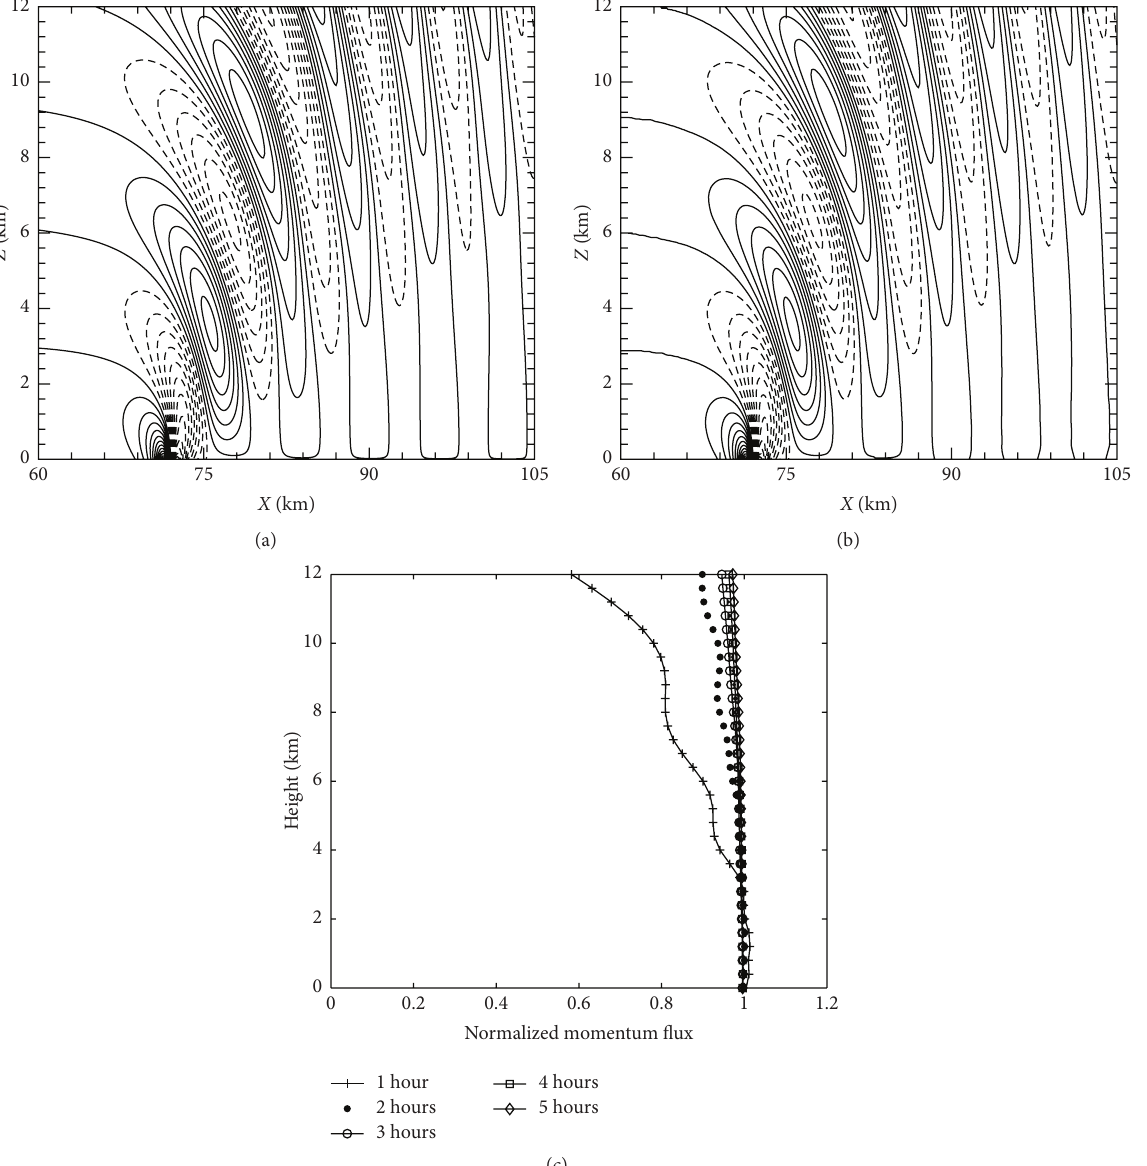
Figure 2: Same as Figure 1, but for linear nonhydrostatic